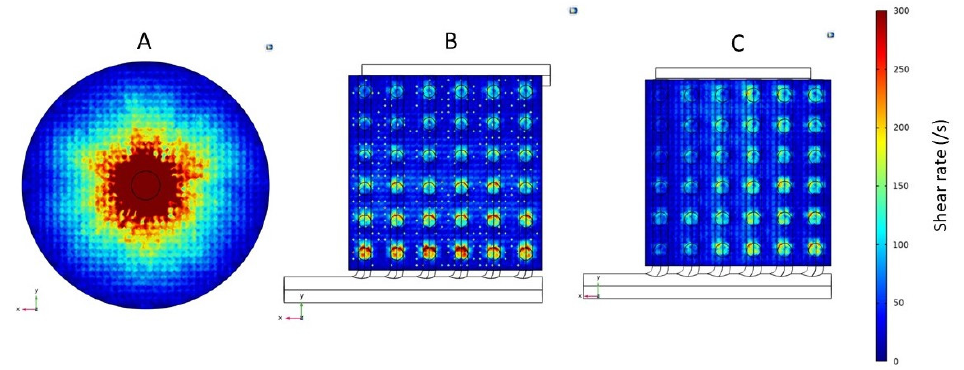
Figure 7. Shear rate profiles for the fiber inlet plane of ( A ) Conventional cylindrical hemodialyzer. ( B ) Cuboid hemodialyzer 1. ( C ) Cuboid hemodialyzer 2.